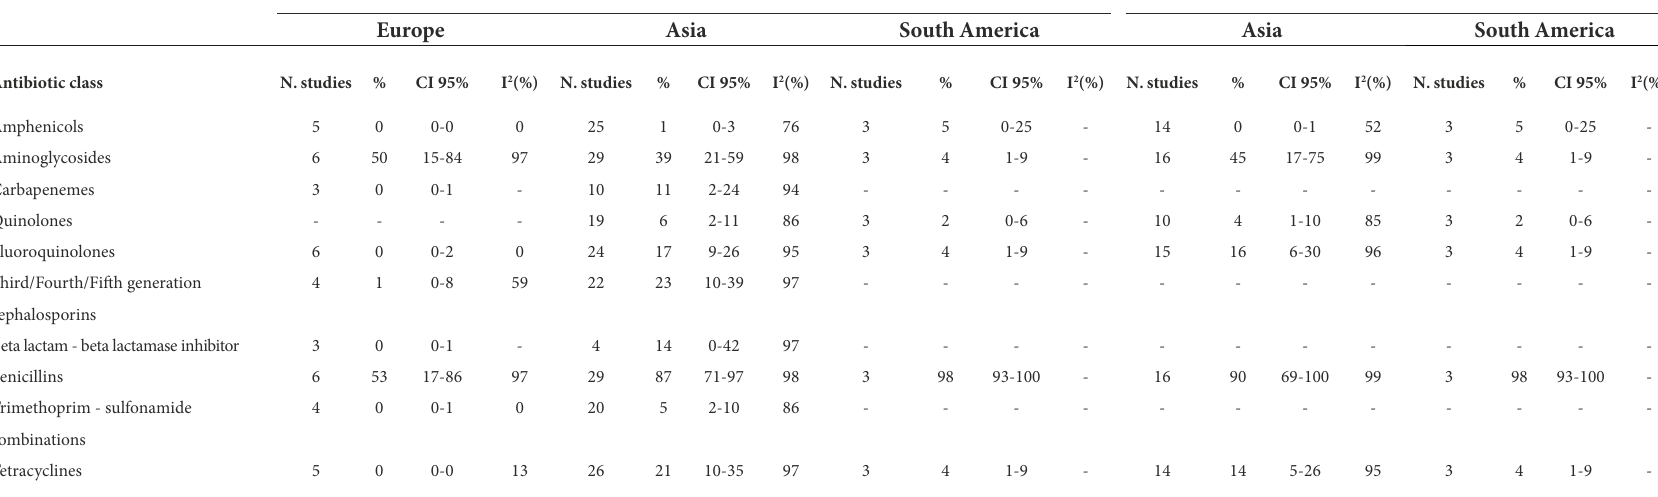
TABLE 2A Number of studied included in the meta-analysis, proportion of resistant isolates (%), 95% Confidence Interval (CI) and I 2 values for each antibiotic